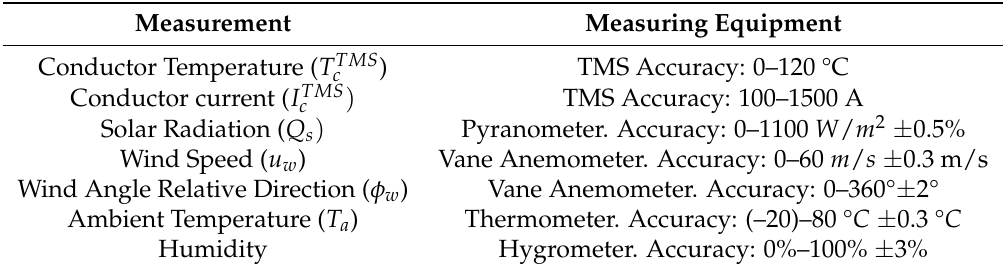
Table 1. Technical data of the measuring equipment.